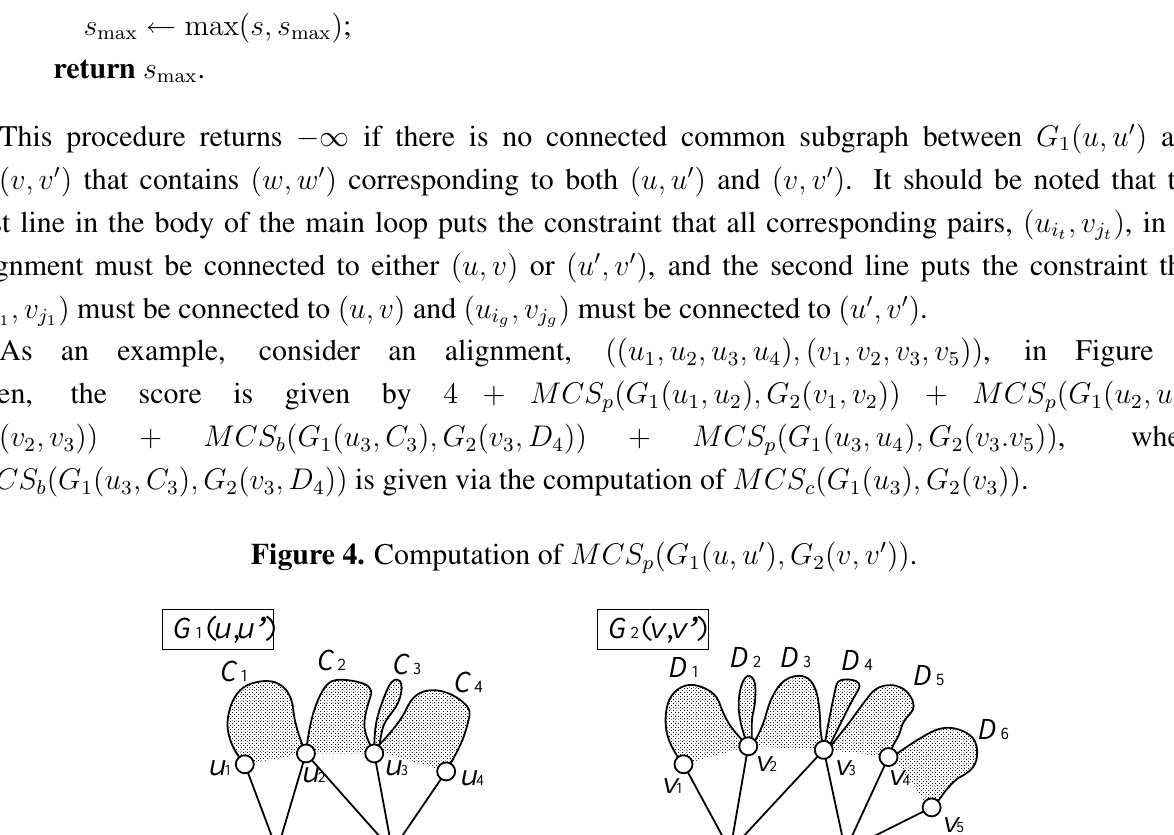
Figure 4. Computation of MCS